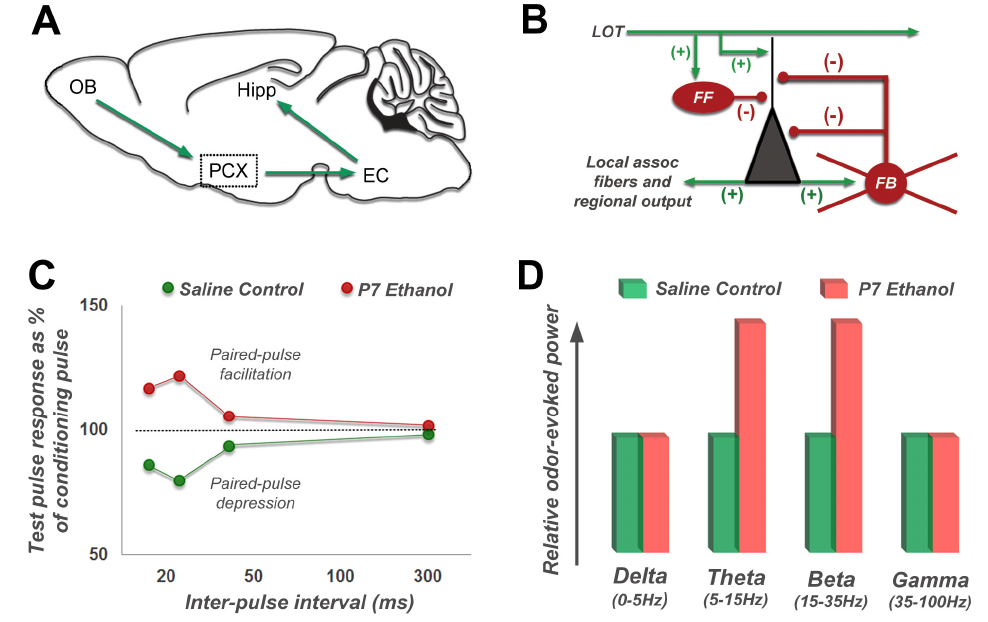
Figure 1. Physiological measurement of neural change in the olfacto-hippocampal pathway of adult mice treated with binge-like ethanol at postnatal day 7. ( A ) Diagram of primary information flow through the olfacto-hippocampal regional circuit. ( B ) Expansion of the piriform cortex (dotted box region in A ) with basic local circuit feedback loop detail, including general modes of local connectivity existing between major cell types (green arrows = excitatory, red knobs = inhibitory). Stimulation from the olfactory bulb (OB) transmits to the piriform cortex (PCX) via the lateral olfactory tract (LOT). As pyramidal cells (grey triangle) are depolarized, associated feedback interneurons (FB) are activated to provide rapid inhibition of subsequent pyramidal cell activity, thus establishing temporally organized PCX processing and distribution of odorant information. ( C ) Idealized LOT-PCX paired-pulse analysis results (adapted from Sadrian et al. 2012 [23] and Wilson et al. 2011 [35]). Adults exposed to saline at P7 exhibit paired-pulse depression with reduced responses to the second test pulse at shorter inter-pulse intervals between the preceding condition pulse. In strong contrast, paired-pulse depression shifts to facilitation in adult mice exposed to ethanol at P7, suggesting dysfunctional local inhibition that is long-lasting. ( D ) Odor-evoked field potentials in the hippocampus were found to be enhanced in P7 ethanol-treated adult mice. Hyperexcitability or inhibitory deficits may also contribute to this type of interregional communication change along the olfacto-hippocampal pathway. Additional abbreviations: EC = entorhinal cortex, Hipp = Hippocampus, FF = feed-forward